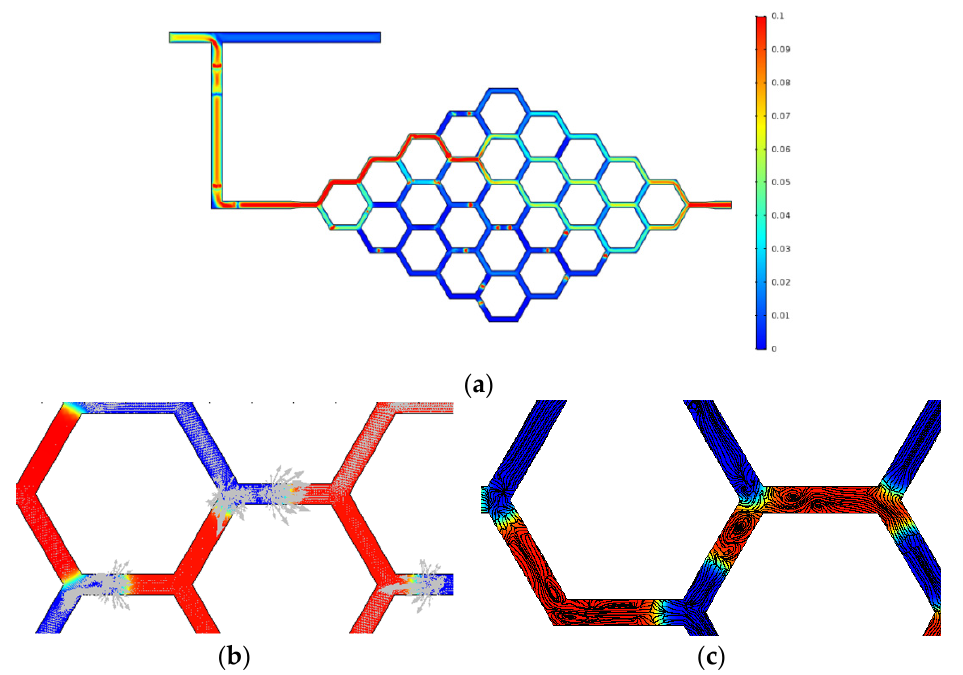
Figure 12. ( a ) Velocity distribution contour under condition 3 (t = 7 s), m/s; ( b ) Velocity vector map under condition 3 (t = 7 s); ( c ) Streamline figure under condition 3 (t = 7 s).